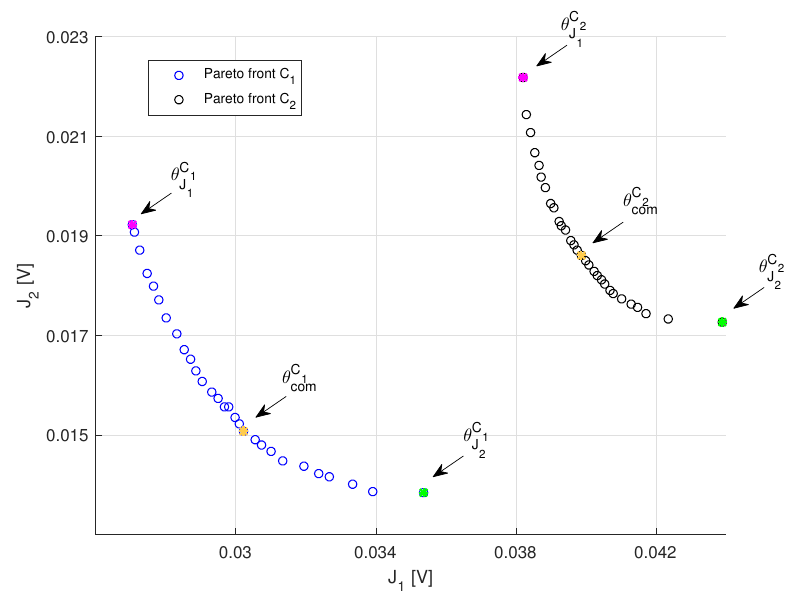
Figure 11. C 1 and C 2 Pareto fronts. The extreme solutions and the compromise solutions—those with the least distance to the utopic solution (the minimum values of J 1 and J 2 ) using the 2-norm—are highlighted.